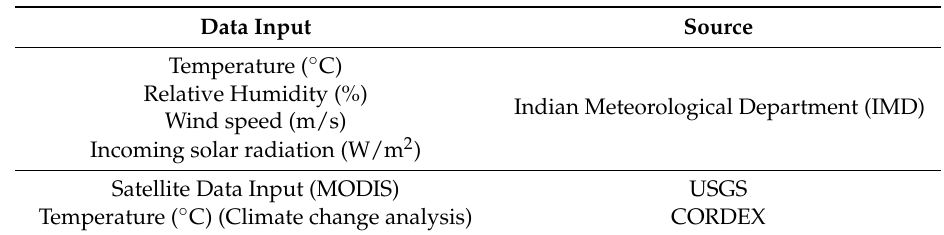
Table 1. Data used for the